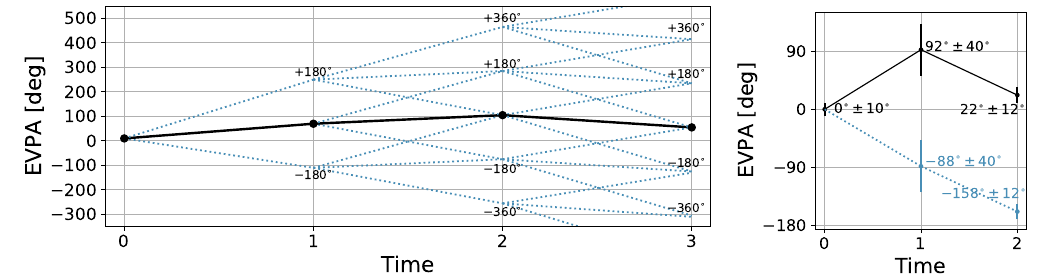
Figure 7. Left panel: an example of a family of EVPA curves demonstrating the 180 ◦ ambiguity. All paths connecting consecutive points in the graph are mathematically equivalent. Only the three most probable escapes for each step are shown. Right panel: an example of a spurious jump in the EVPA curve introduced by the 180 ◦ ambiguity solution